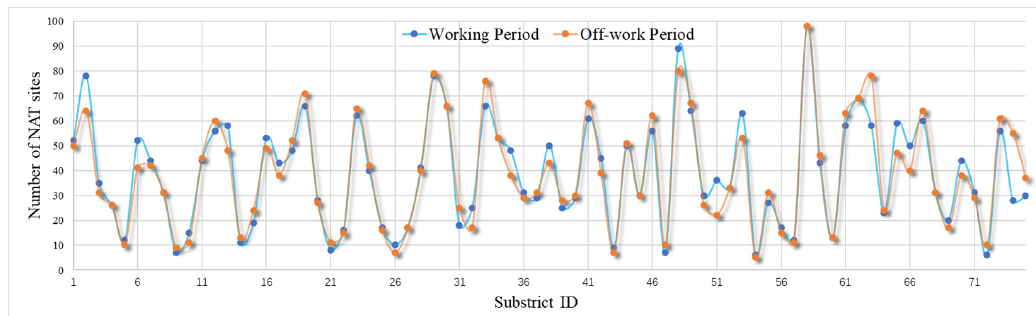
Figure 9. Comparison of the number of NAT sites in different regions and periods.